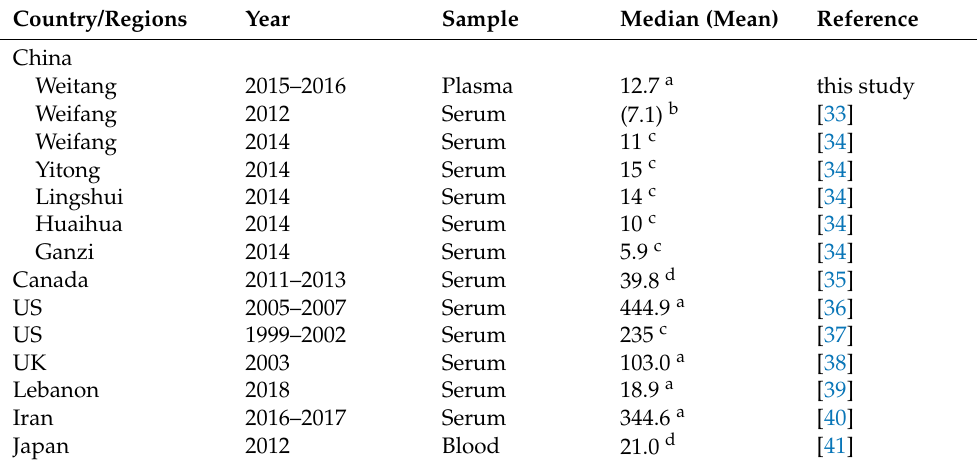
Table 4. Concentrations of PCBs in non-occupationally exposed populations from blood samples (ng/g Lipid) collected from other regions or